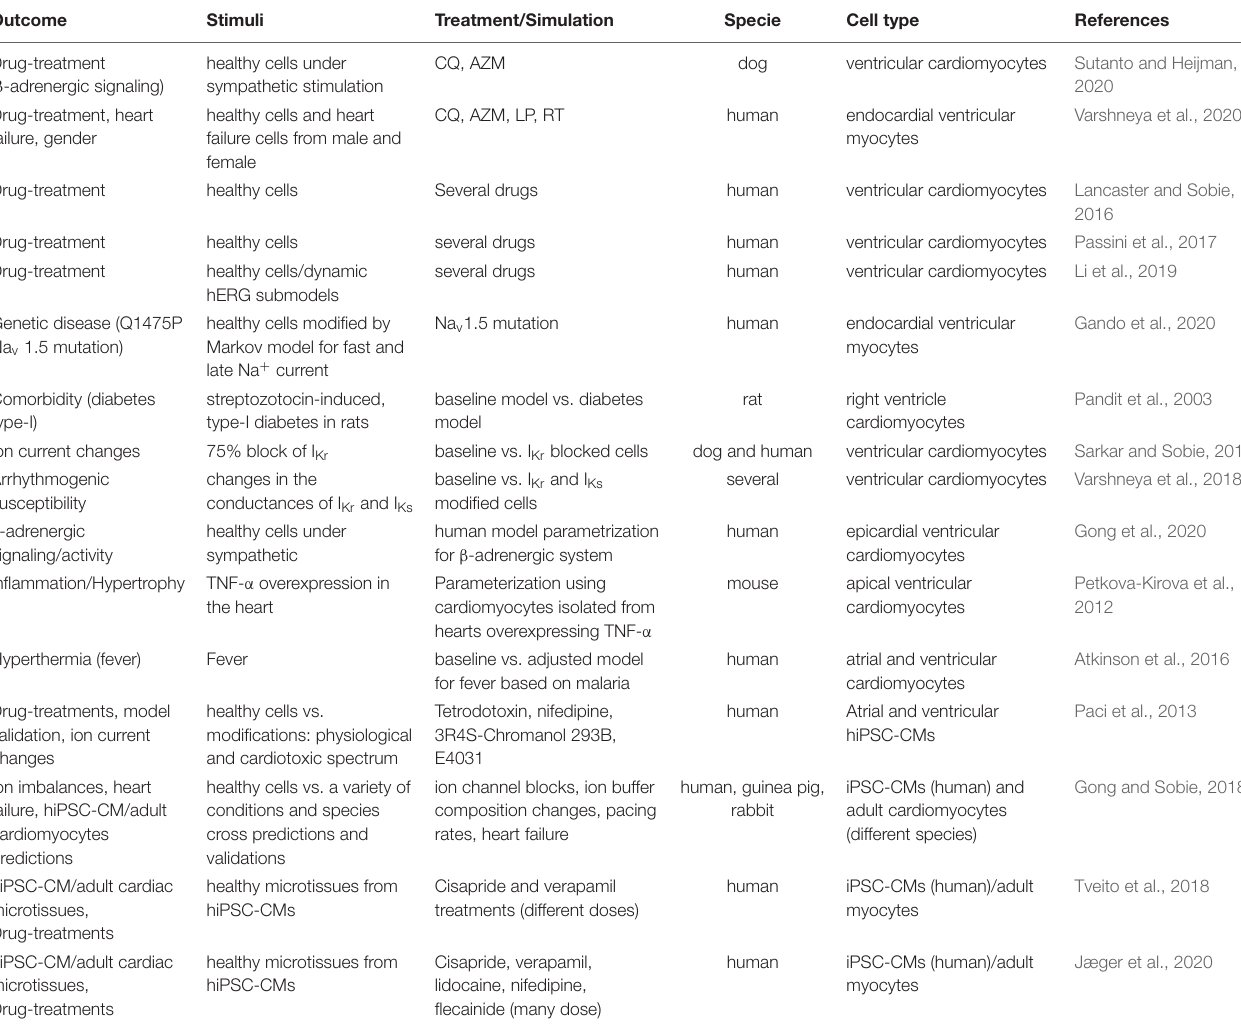
TABLE 2 | In silico models to be used to mimic “COVID-19